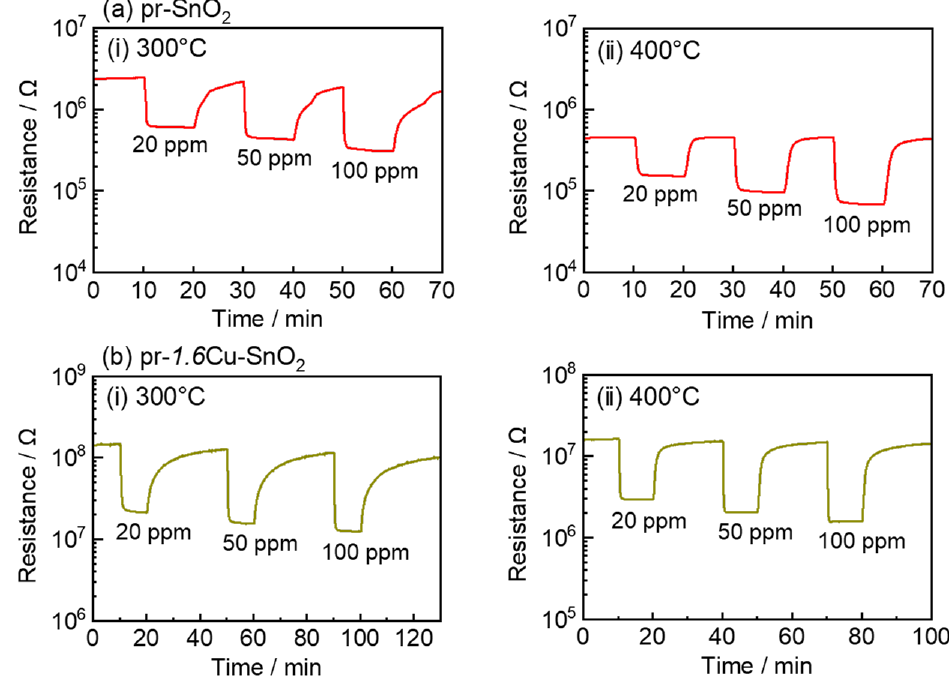
Figure 7. Response transients of ( a ) pr-SnO 2 and ( b ) pr- 1.6 Cu-SnO 2 sensors to 20, 50, and 100 ppm acetone at (i) 300 °C and (ii) 400 °C in air.